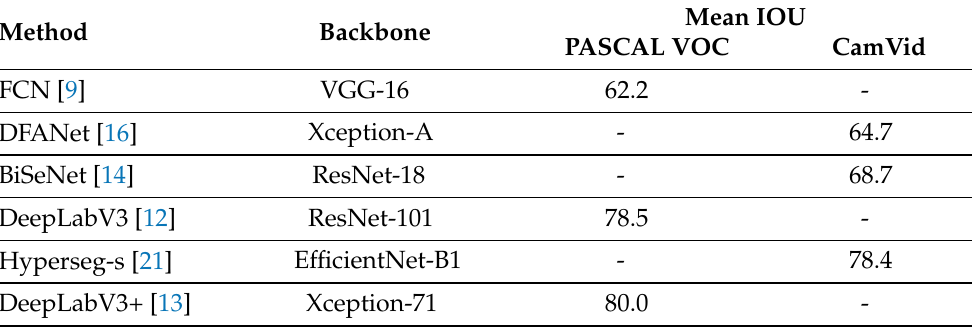
Table 1. Accuracies of segmentation models on the PASCAL VOC [19] 2012 val and CamVid [20] test